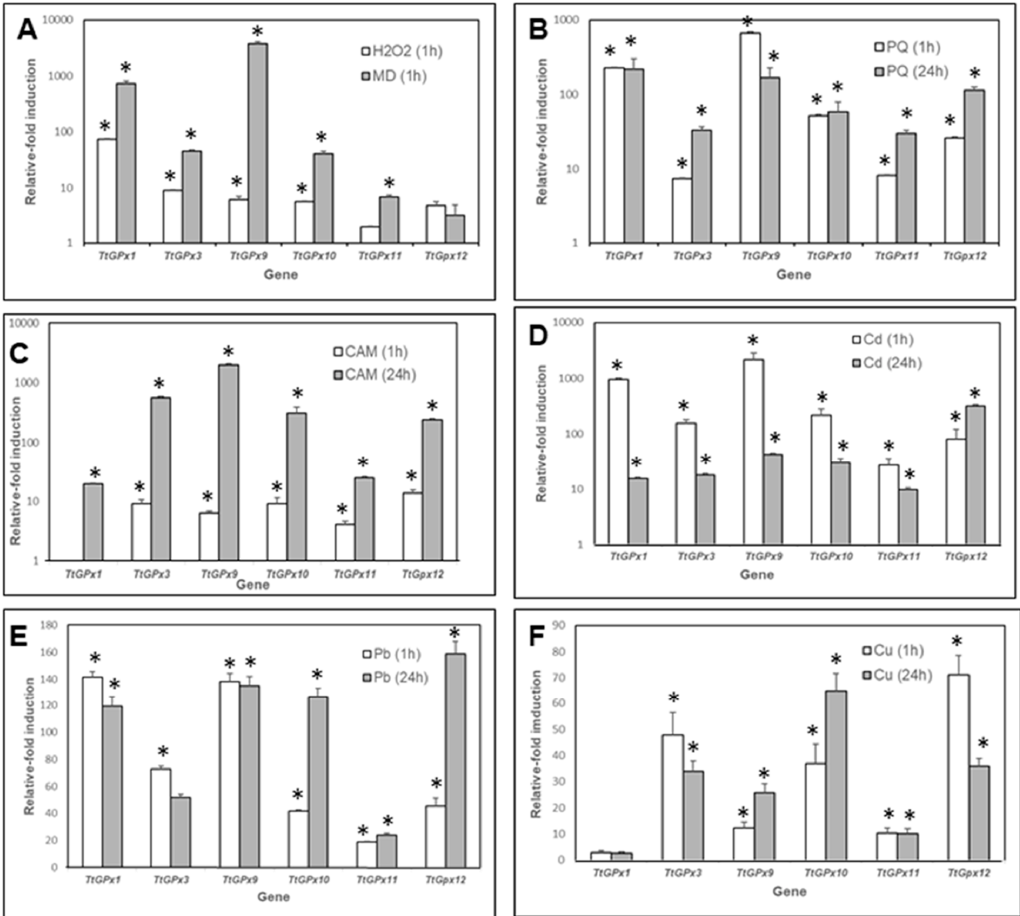
Figure 3. Quantitative RT-PCR results from six putative TtGPx genes, under different stressful conditions; ( A ) hydrogen peroxide or menadione (MD), ( B ) paraquat (PQ), ( C ) camptothecin (CAM), ( D ) cadmium, ( E ) lead and ( F ) copper, at 1- or 24-h treatments. Histogram bars correspond to an average value ± SD of two or three independent experiments. Asterisks indicate significant differences